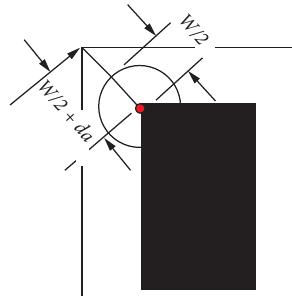
Figure 10: Obstacle expansion.